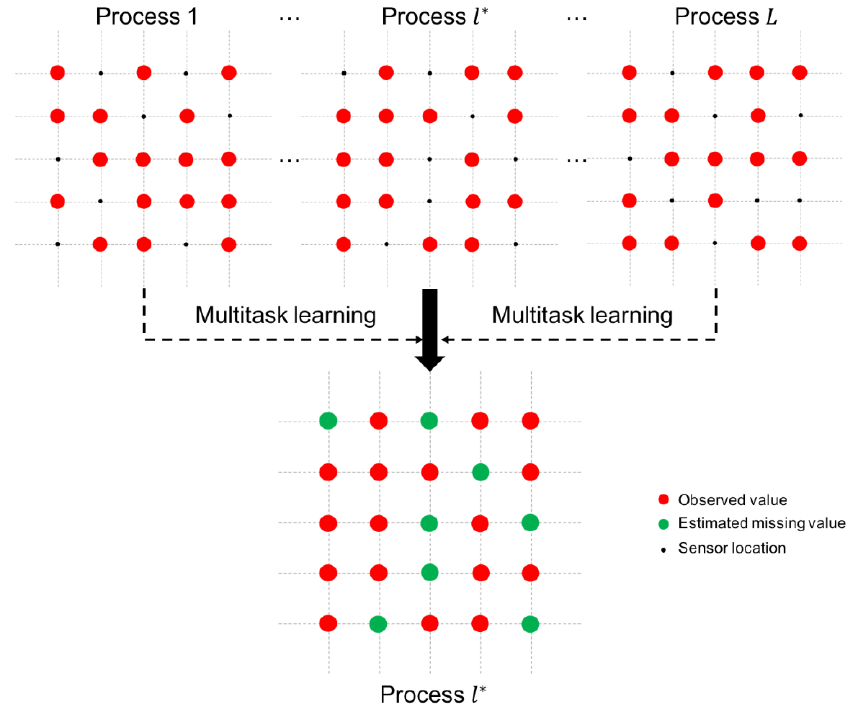
Figure 2. Multitask learning for estimating missing values.